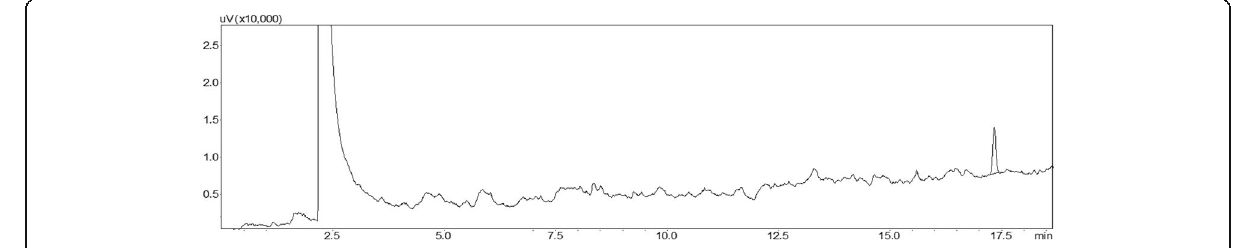
Fig. 4 Chromatogram of squalene in ethanolic extract of Clerodendrum serratum